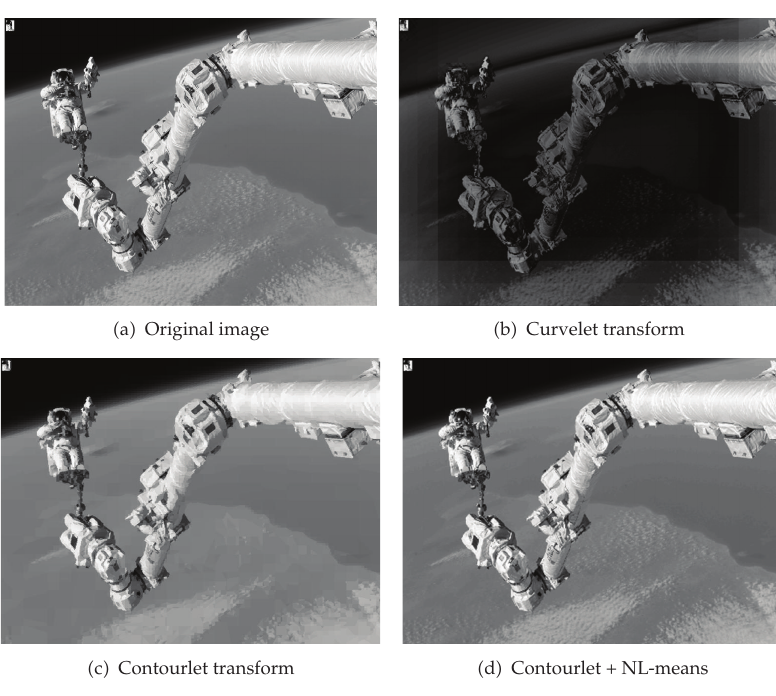
Figure 6: Process results for image I.